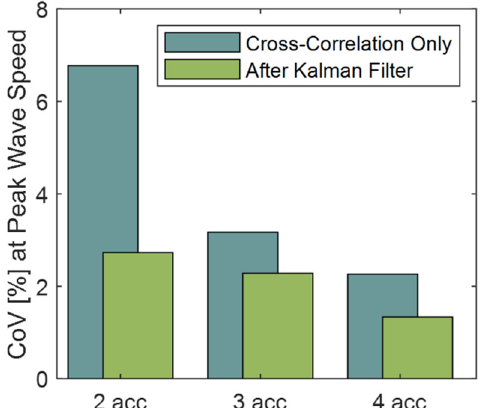
Figure 8. The coefficient of variation (CoV) at peak wave speed was reduced dramatically by using a Kalman filter to process simulated tensiometry data with two accelerometers. Increasing the number of accelerometers further reduced the errors in wave speed estimates. The data shown were from simulated gait cycles with a signal to noise ratio (SNR) of 4.